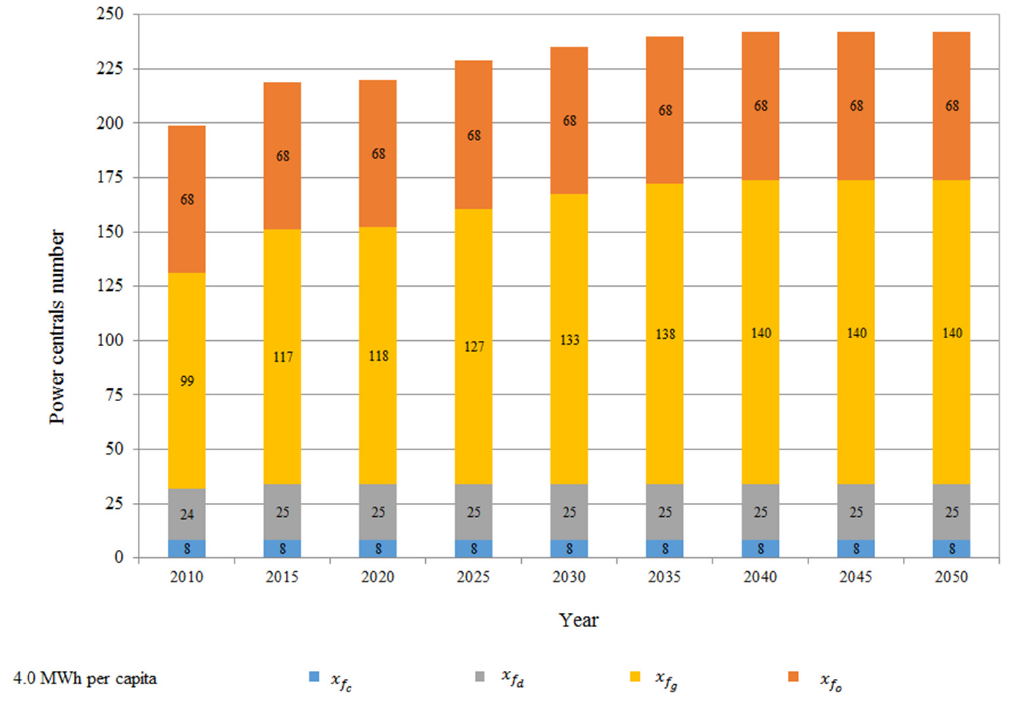
Figure 19. Optimized power plants number from fossil energy resource for 4.0 MWh per capita demand with the CVF model.